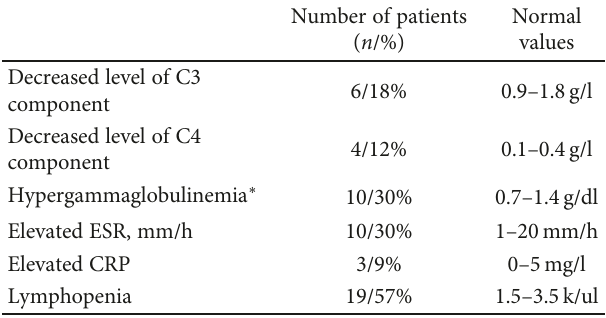
Table 1: Selected laboratory parameters in pSS patients.